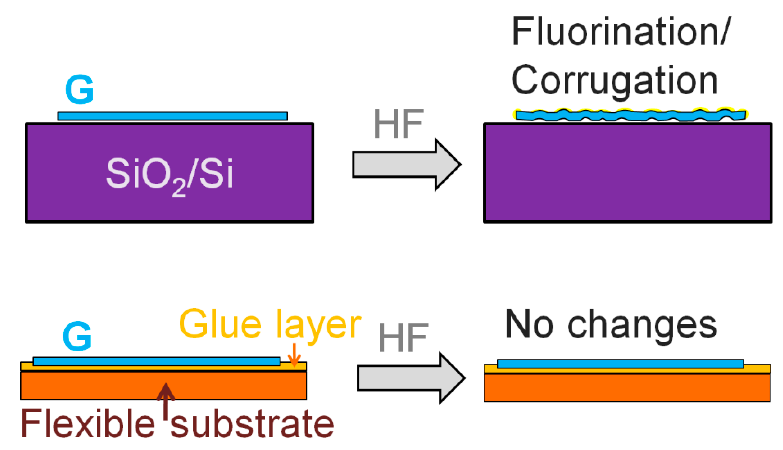
Figure 8. Schematic representation of the differences in the graphene fluorination process on the rigid and flexible substrates.